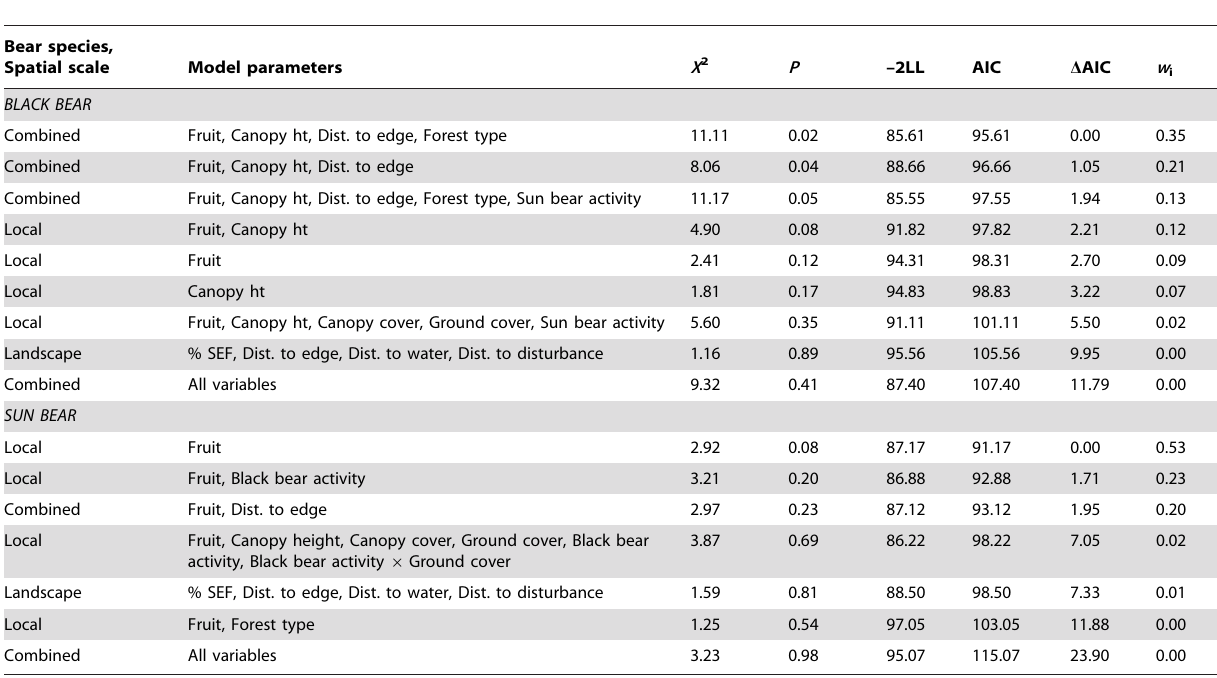
Table 3. Comparison of logistic regression models of habitat attributes influencing occurrence of black bears and sun bears in Thung Yai Naresuan Wildlife Sanctuary, Thailand, 2001–2003.